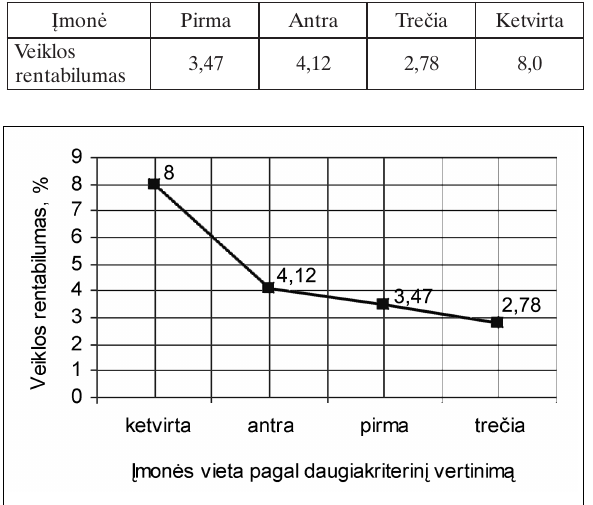
Table 5 . Profitability of commercial activities of the